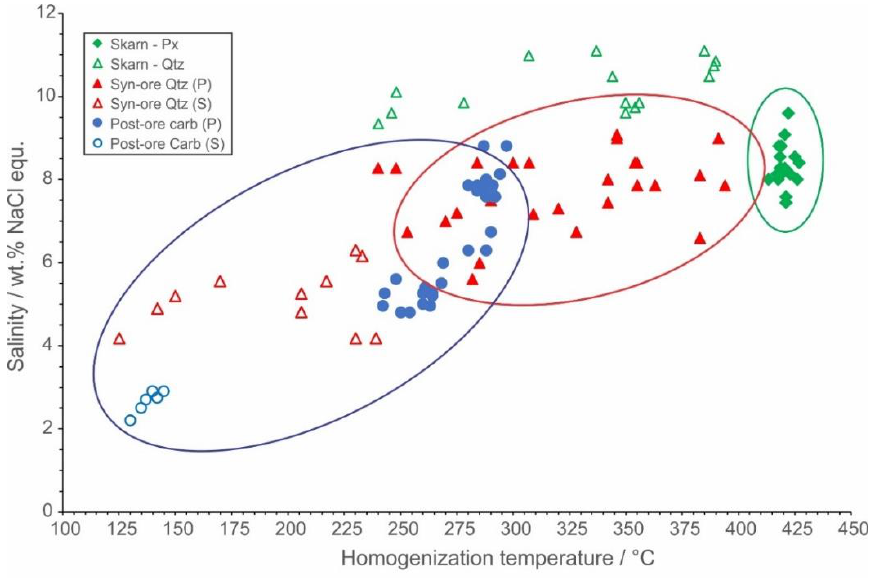
Figure 15. Correlation of homogenization temperature and salinity for fluid inclusions in skarn, syn-ore and post-ore minerals.